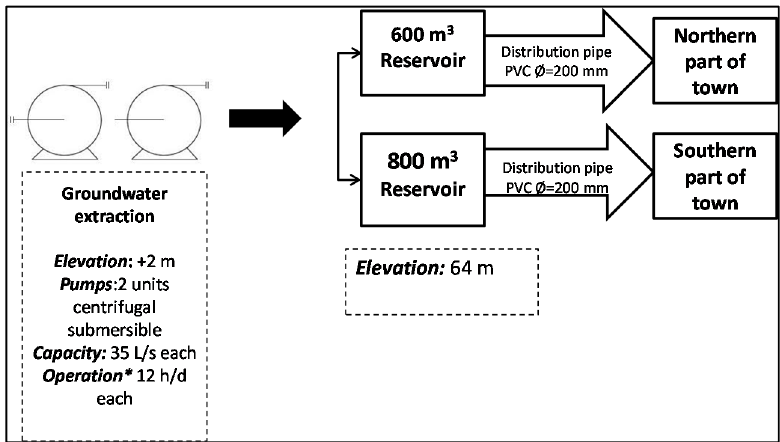
Figure 2. Current layout of Puerto Ayora water supply system; * Operation is only 12 h per day due to lack of sufficient power capacity for the three existing pumps to operate full time. As a result, only two operate at the same time for the specified period.